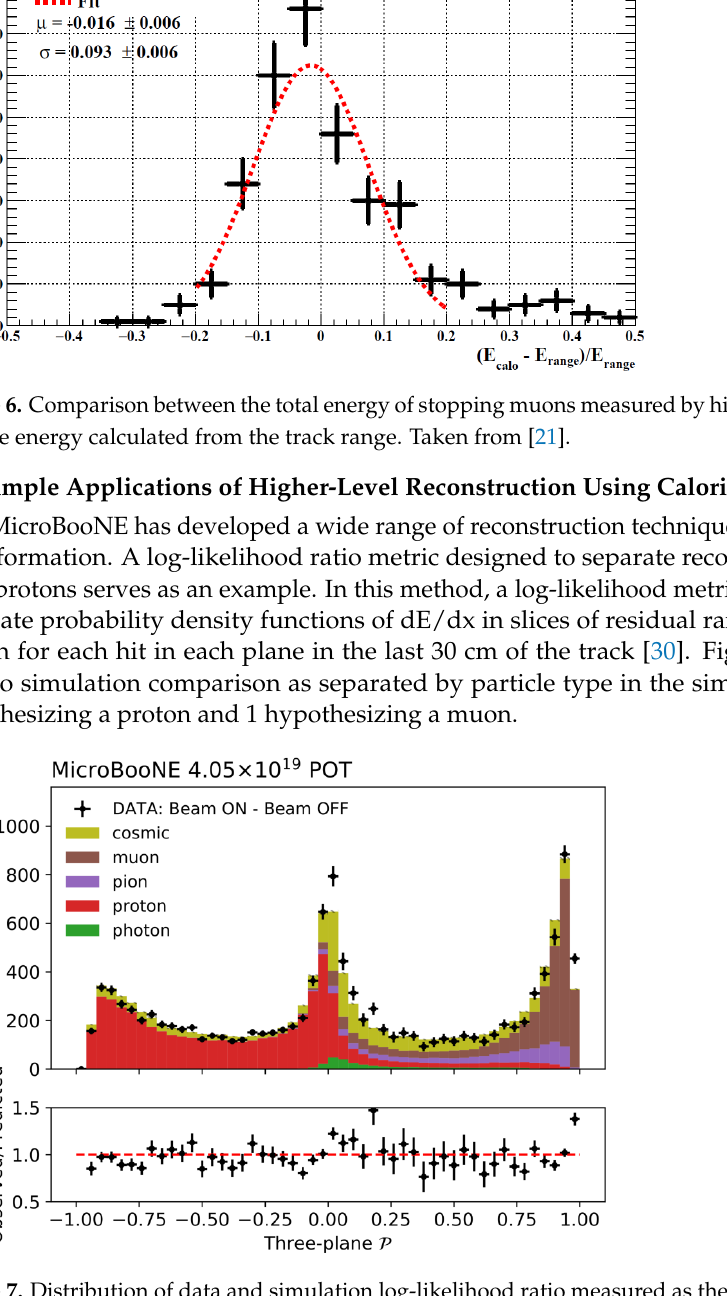
Figure 7. Distribution of data and simulation log-likelihood ratio measured as the difference between beam on samples and beam off samples to eliminate the cosmic background. With the Poisson uncertainties on the data distribution, the simulation and data appear within agreement. The image is from